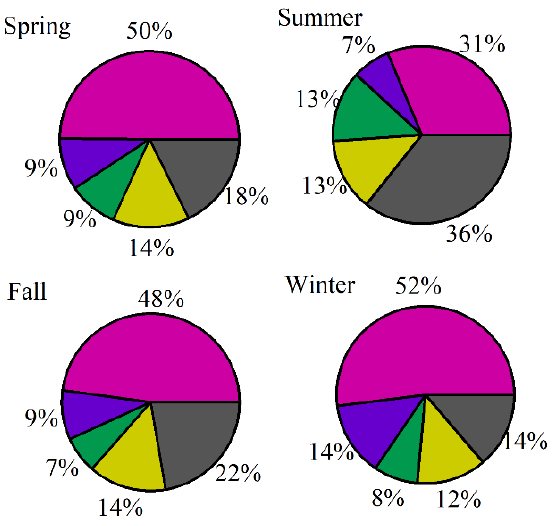
Figure 3. Composition of VOC mixing ratios in spring, summer, fall, and winter.